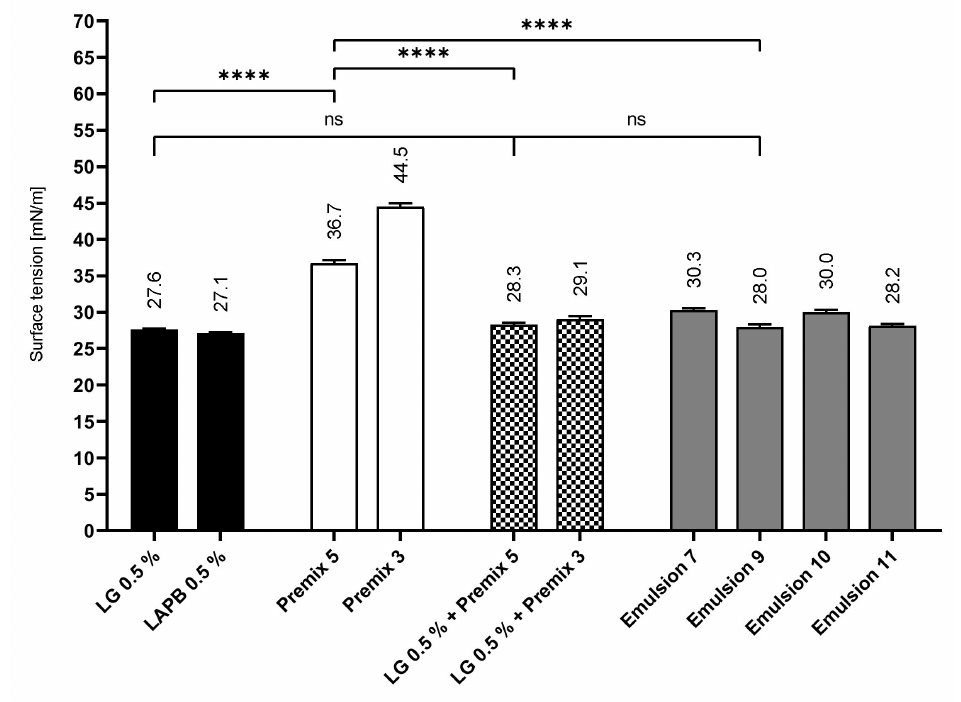
Figure 10. Surface tension of the PL emulsions and precursors; mean ± SD, n = 5; **** p ≤